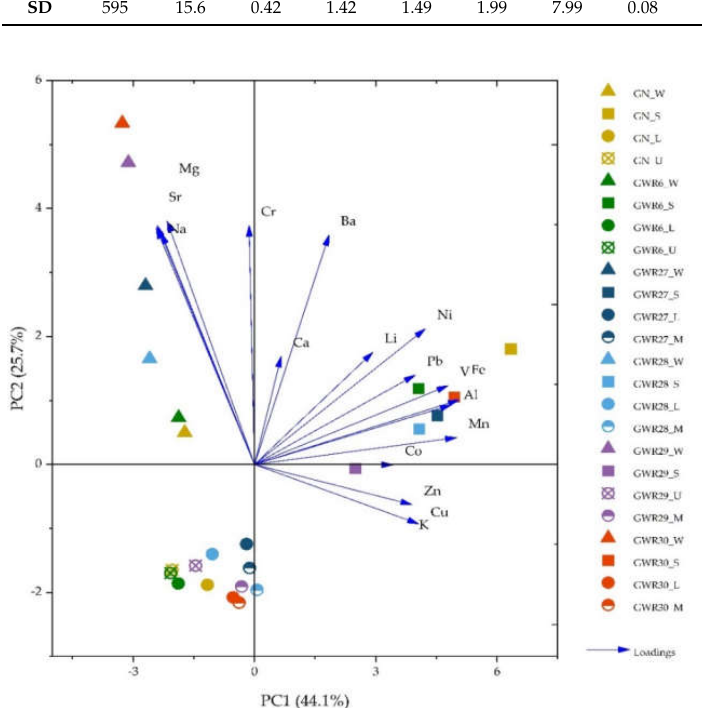
Figure 5. Principal component analysis (PCA) of variation of macro- and microelements in water, soil, and plant samples (L— Lolium sp., U— Urtica sp., and M— Mentha sp.) in Banat (GN, GWR6) and Dobrogea region (GWR27, GWR28, GWR29, and GWR30).